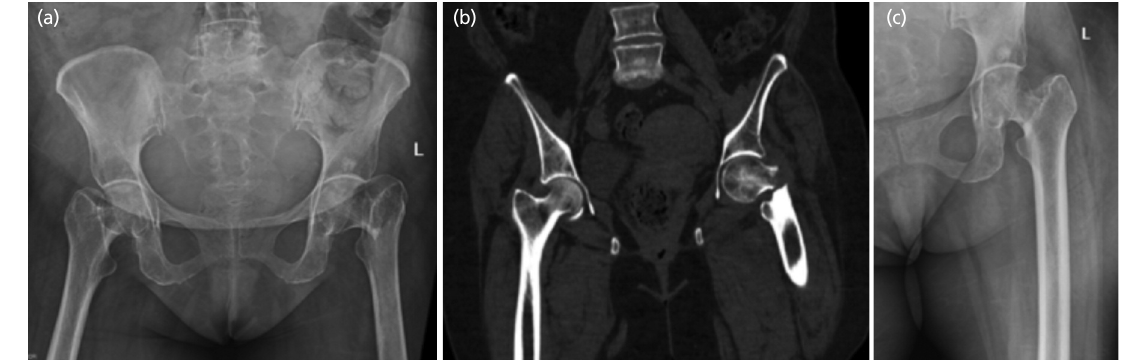
Case example from control group showing a 53-year-old female with Singh index 4 having a left hip basicervical fracture (a) Fig. 4: pelvis radiograph AP (b) mid coronal CT image (c) traction internal rotation view of left hip.